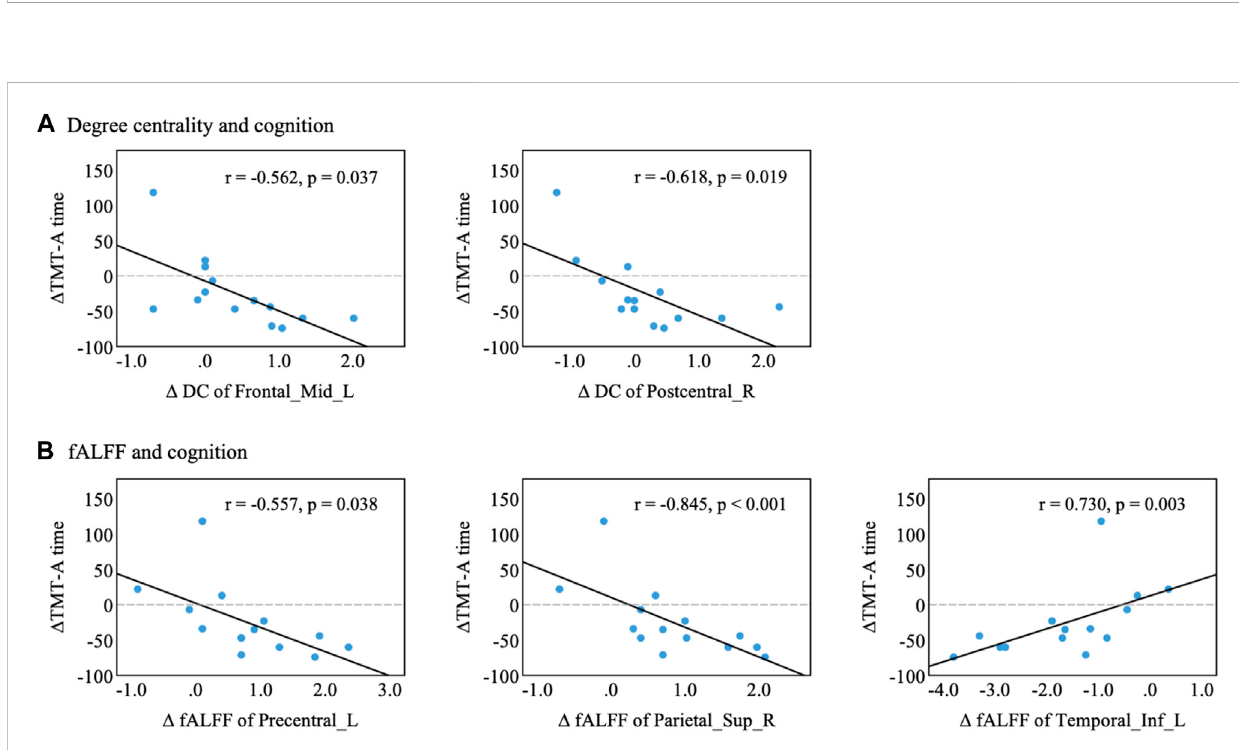
FIGURE 6 Correlation between altered brain function and cognitive performance in the NXA group. (A) Changes in degree centrality were associated with cognitive decline. (B) Changes in fALFF were associated with cognitive decline. Changes in index variability were computed as the difference ( Δ index = indexfollow-up-indexbaseline)betweenbaselineandfollow-upforeachparticipant.Abbreviations:Mid=middle,Sup=superior,Inf=inferior,L=left,R =